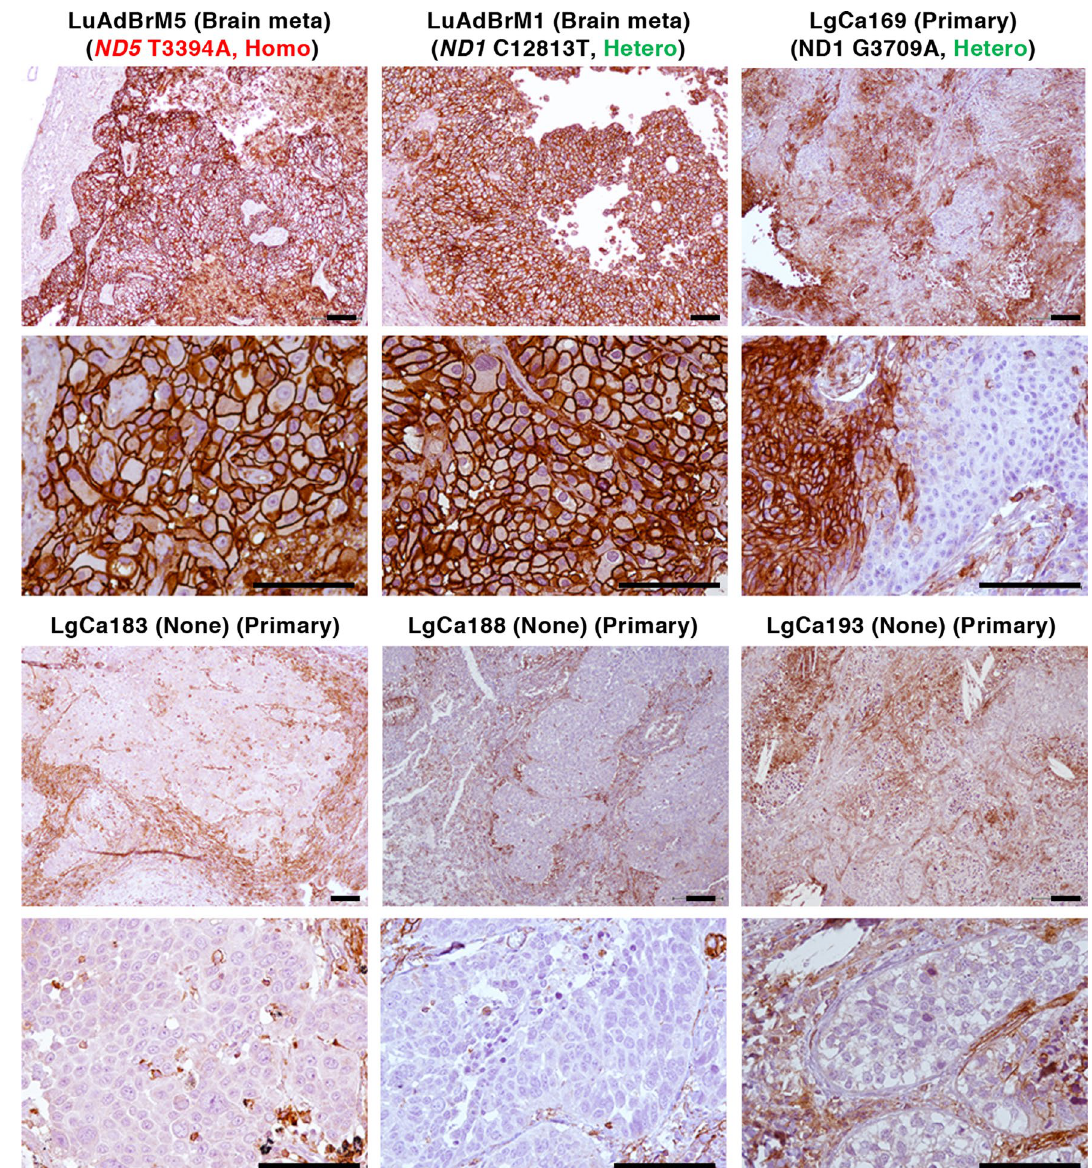
Figure 5. IHC analysis of MCT4 expression in NSCLC tissues. NSCLC tissues harbouring predicted pathogenic ND mutations such as homoplasmy (LuAdBrM5) or heteroplasmy (or heterogeneous state) (LuAdBrM1 and LgCa169) and NSCLC tissues having no pathogenic ND mutation (LgCa183, LgCa188 and LgCa193) were immunostained for MCT4 using a monoclonal MCT4 antibody. LuAdBrM5 and LuAdBrM1 tissues were strongly positive for MCT4 on cell membranes. LgCa169 tissues contain both MCT4-positive and MCT4- negative regions, which might represent cancer cells with and without the mutation, respectively. Cancer cells in LgCa183, LgC188 and LgCa193 tissues were negative for MCT4, but stromal cells were positive. Bar: 100